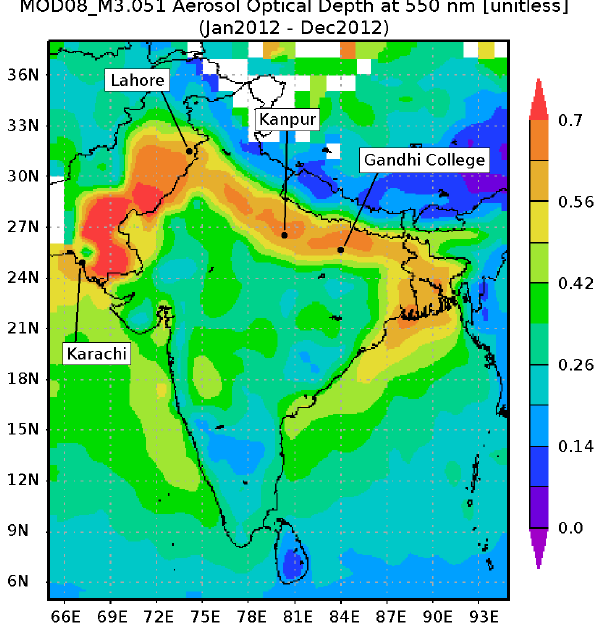
Figure 1. Annual mean AOD from MODIS Terra, with our AERONET study sites overlaid in the map. Source of MODIS data: http://disc.sci.gsfc.nasa.gov/giovanni.